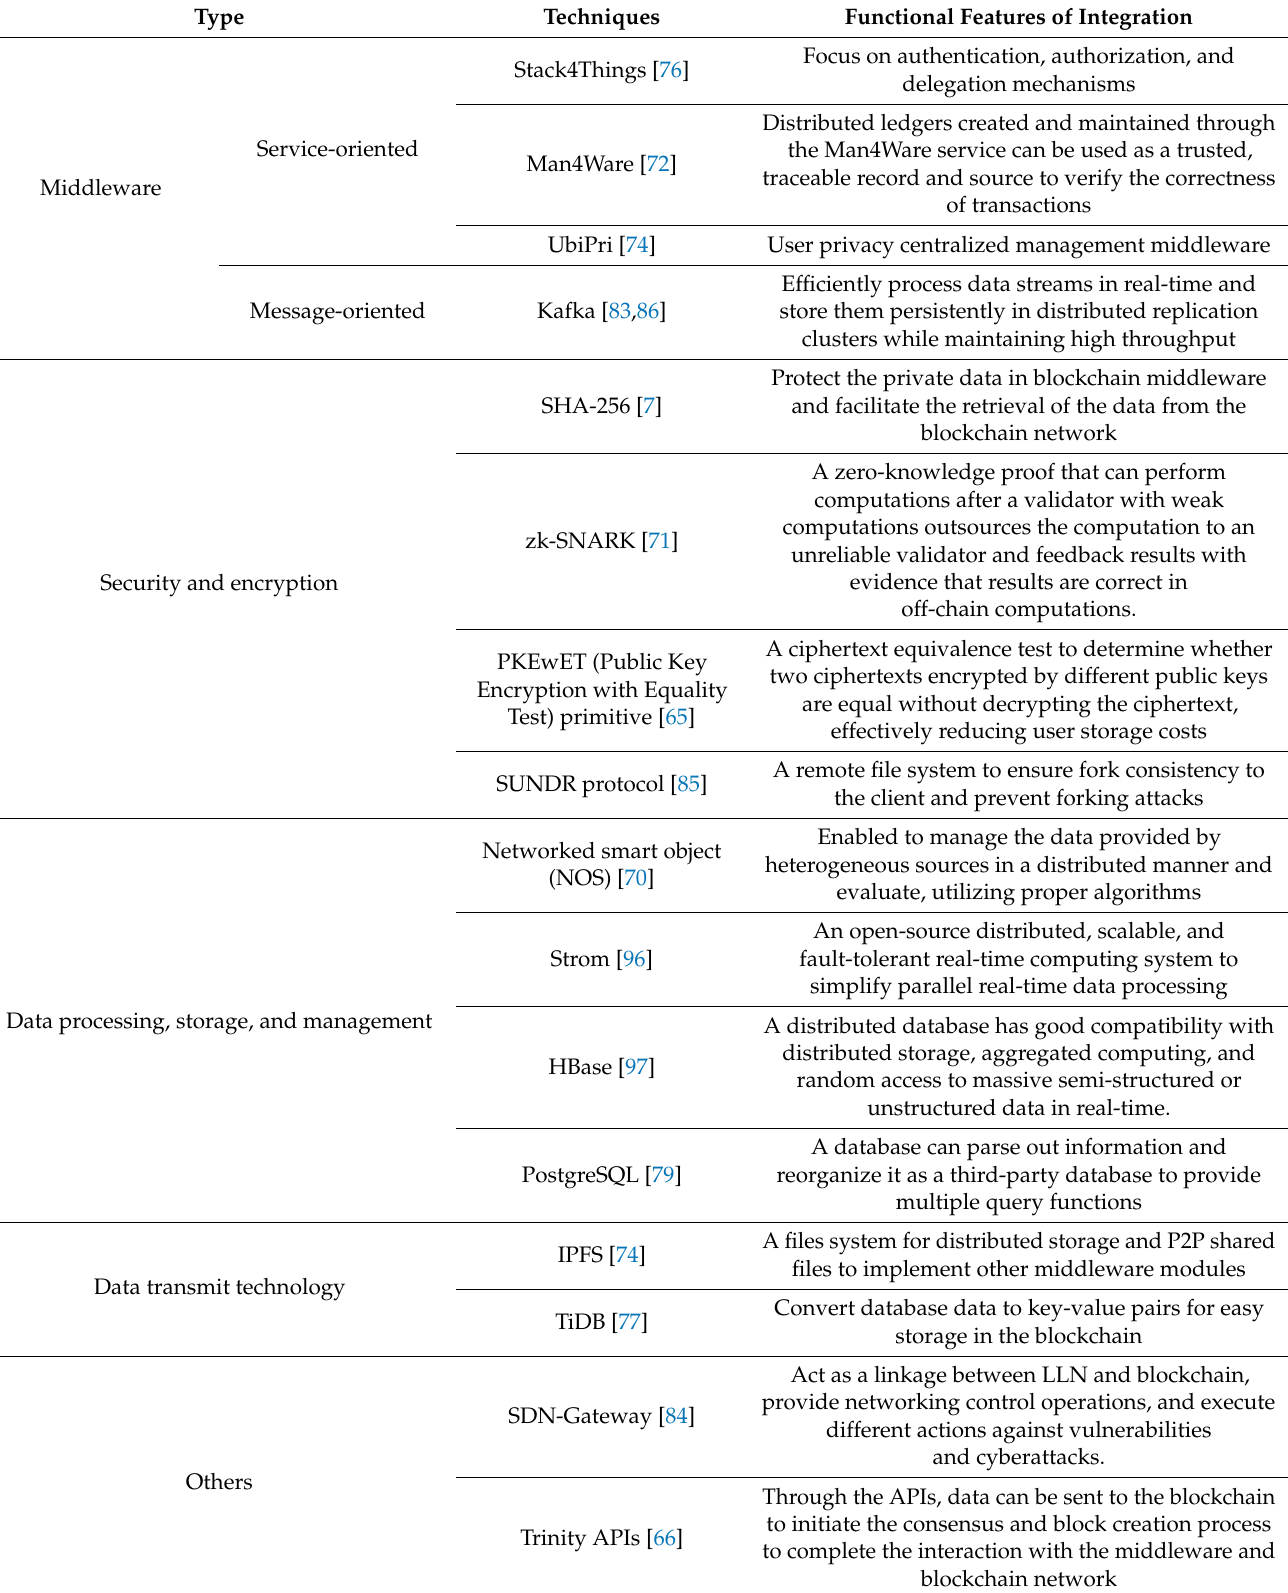
Table 5. Enabling technologies for the middleware